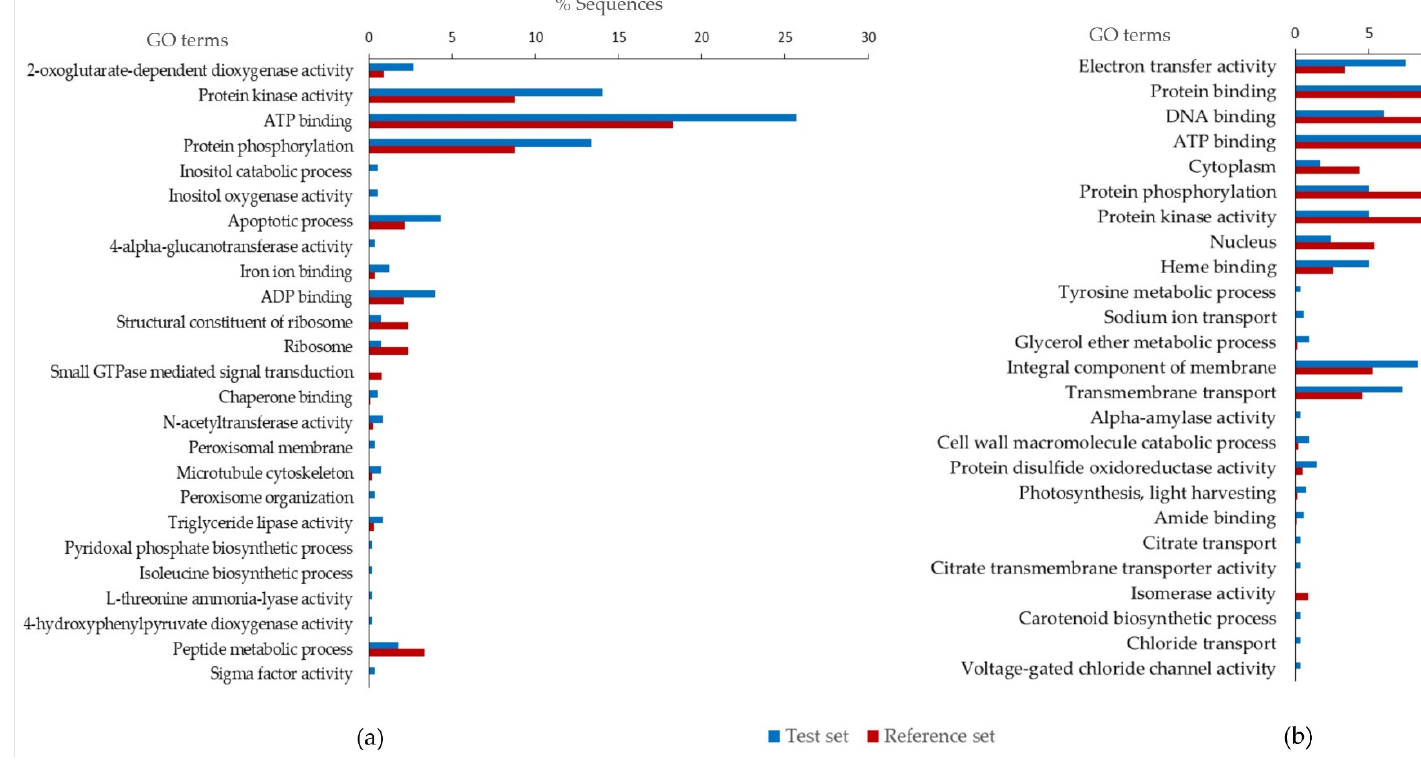
1 and >1 were selected for this −